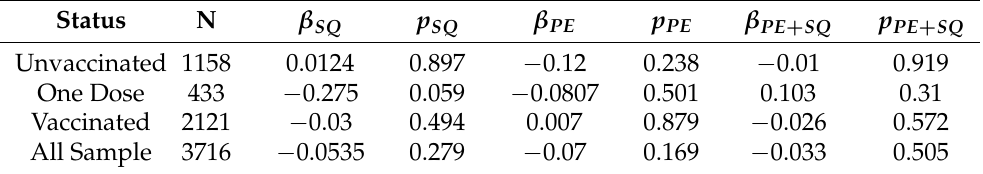
Table 4. OLS beta coefficients deriving from regressions with the intention to get vaccinated as the dependent variable and a binary variable to measure the impact of being in the treatment groups with respect to the Control group. The regressions are ran controlling for demographics, vaccination status, frequency of travel and trust levels of the participants. Tables of the regressions output are included in supplementary materials (Tables